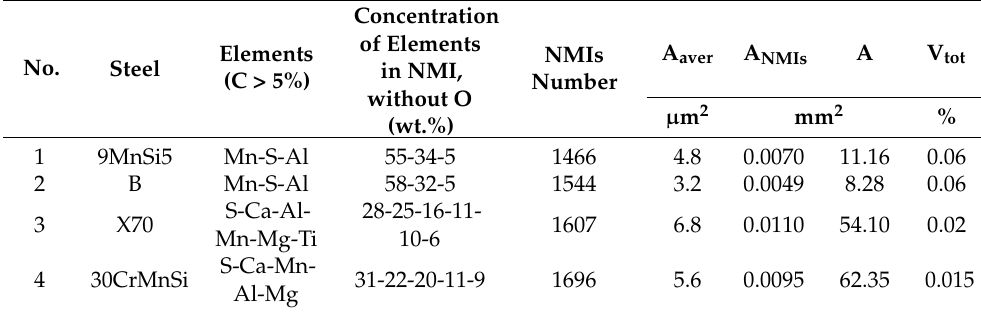
Table 2. Average chemical composition, the number of inclusions in the databases after